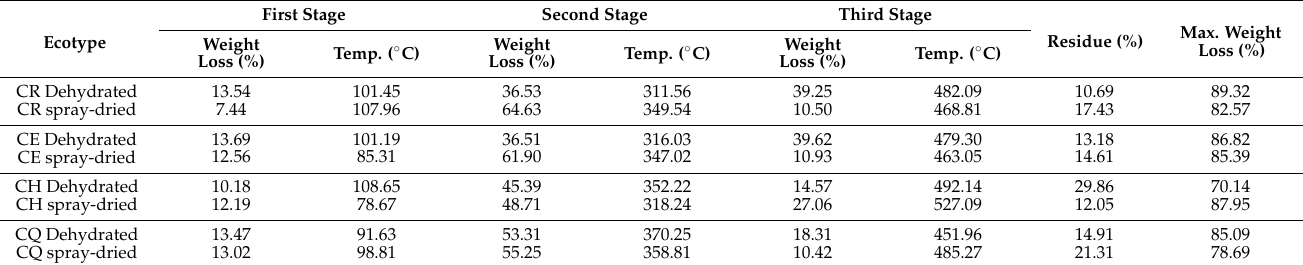
Figure 4. TGA curve for nostoc ecotypes. Table 7. Lost weight and decomposition